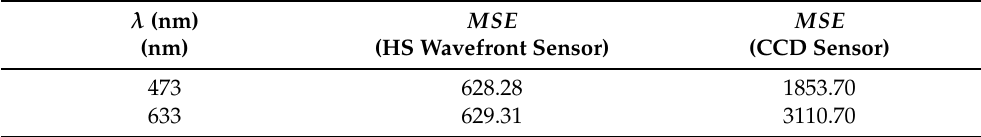
Figure 9. Convolution simulations of an object test (University of Alicante logo) with the ASFs obtained by the different methods: HS wavefront sensor and CCD sensor. Table 5. Mean Squared Error (MSE) at 473 and 633